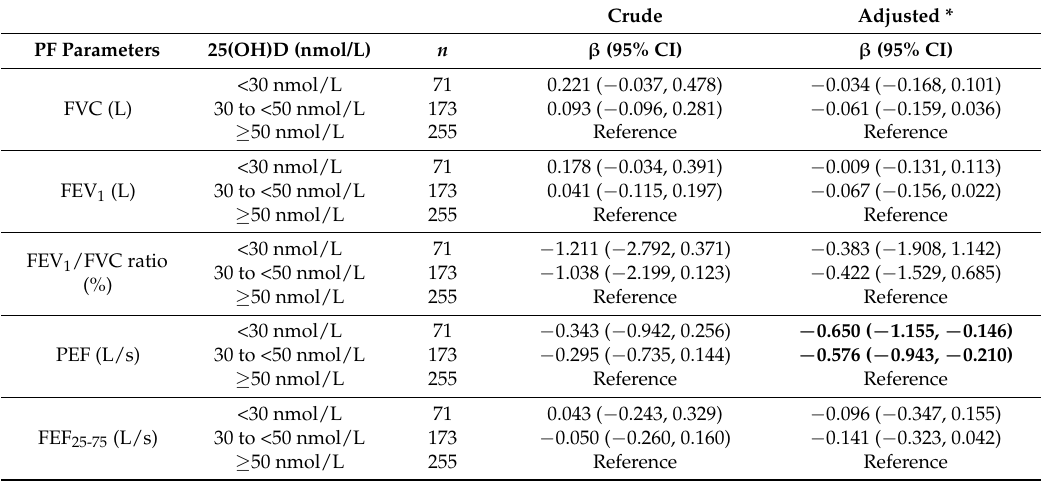
Table 5. Association of serum 25(OH)D categories with pulmonary function (PF)